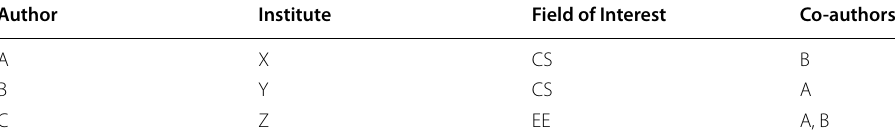
Table 2 An example of dataset of Google Scholar authors for constructing networks